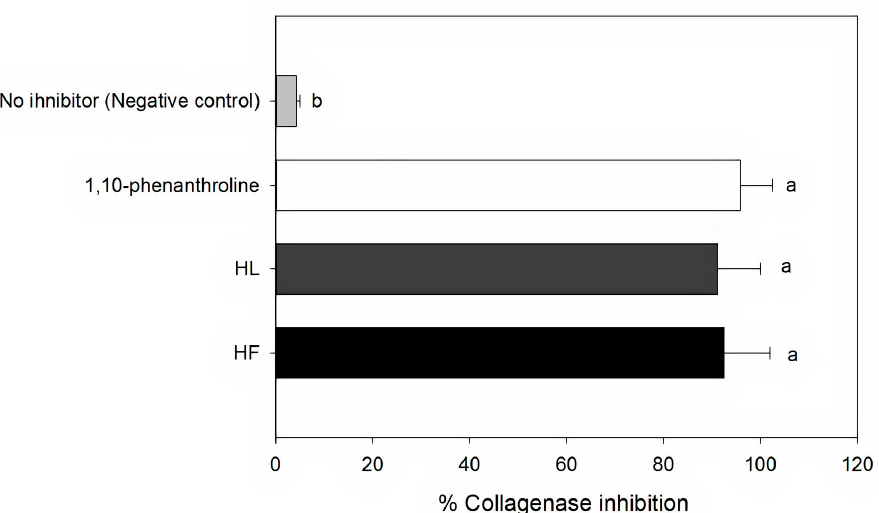
Figure 2. Collagenase inhibitory activity (in percentage) of extracts of Hibiscus roseus flowers (HF) and leaves (HL) at 0.25 mg mL − 1 , and controls (negative control—no inhibitor—and 1,10-pheanthroline 1M—positive control). Mean values and standard deviation ( n = 3), different letters indicate significant differences among the samples ( p ≤ 0.05).